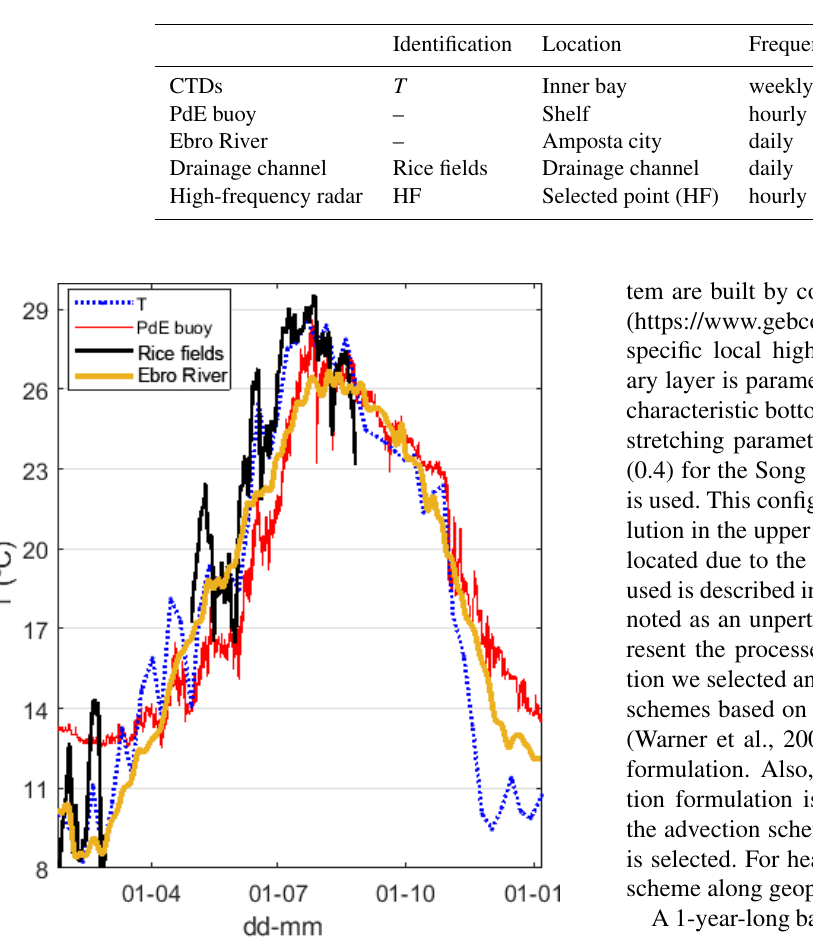
Figure 2. Water temperatures in Alfacs Bay at point T (year 2014), drainage channels (rice fields, from climatological observations for 2002–2010 in a nearby coastal lagoon by the staff of the Ebro Delta Natural Park), Tarragona buoy (Tb) for open seawater conditions (Puertos del Estado, PdE) and climatological data from the Ebro River (Confederación Hidrográfica del